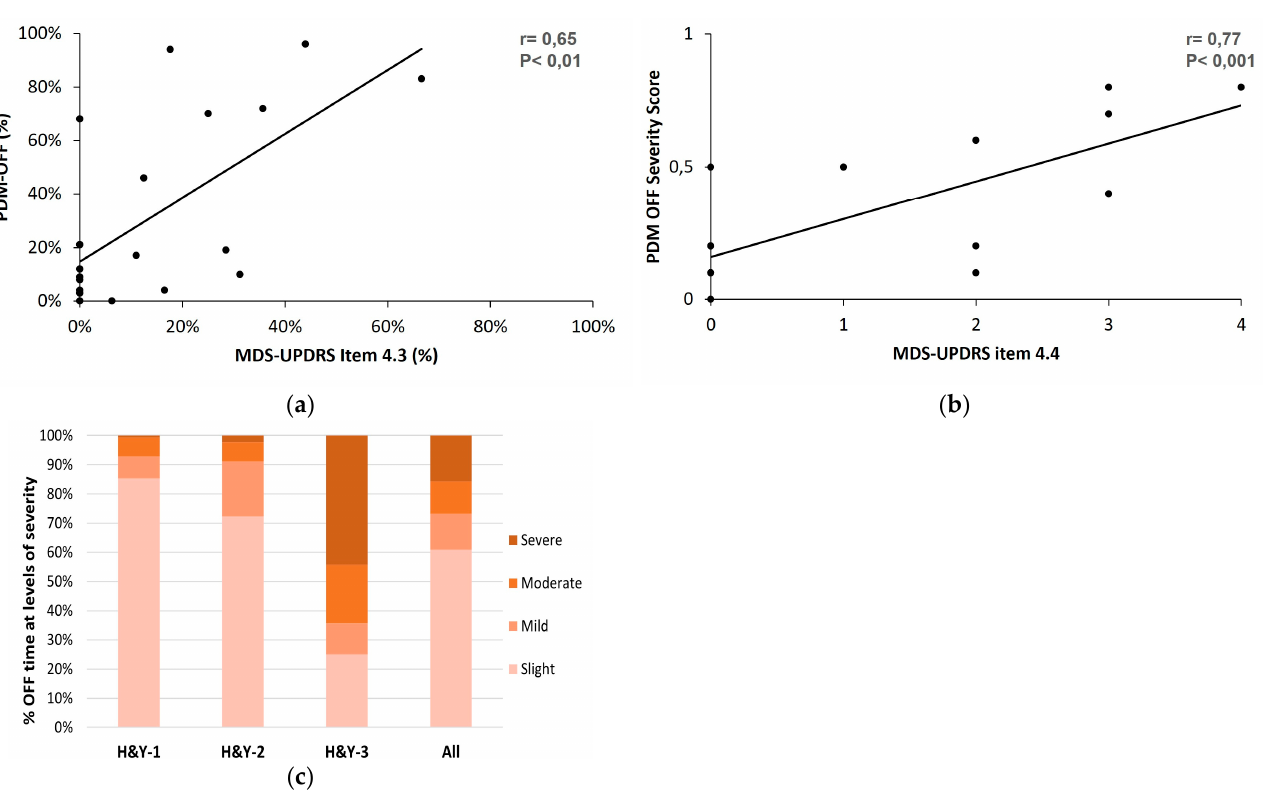
Figure 10. The correlation plots between the PDMonitor ® and the MDS-UPDRS using the Pearson’s correlation of ( a ) PDMonitor ® percent of time OFF and MDS-UPDRS item 4.3; ( b ) PDMonitor ® OFF severity score and MDS-UPDRS item 4.4 score; ( c ) the %OFF time at severity levels.